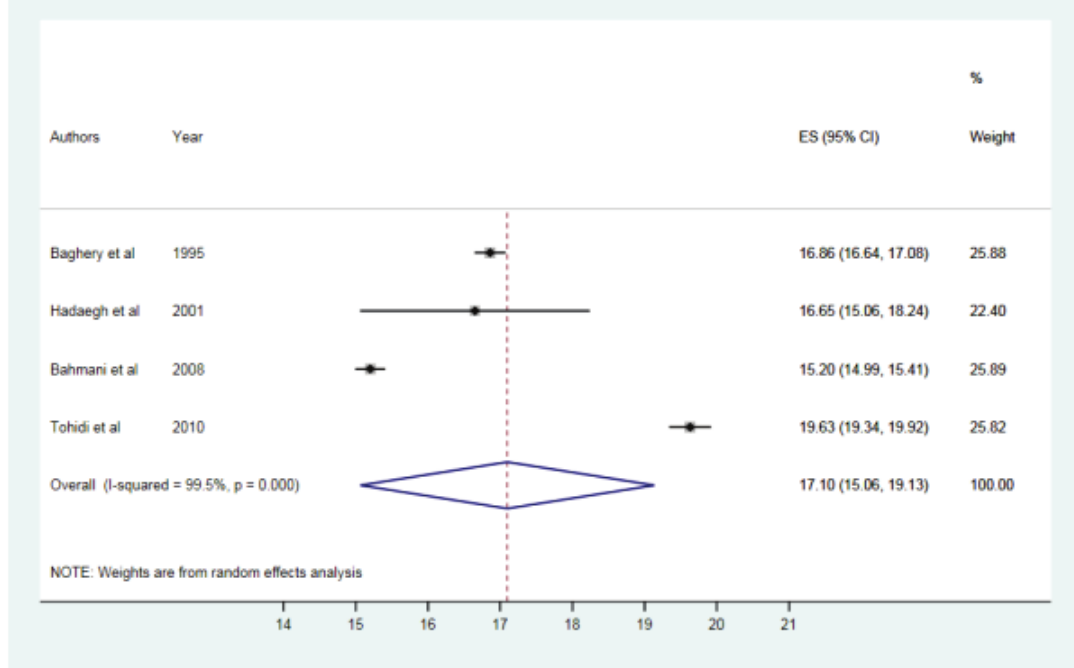
Figure 2. Mean eye protrusion in 13–19 years age